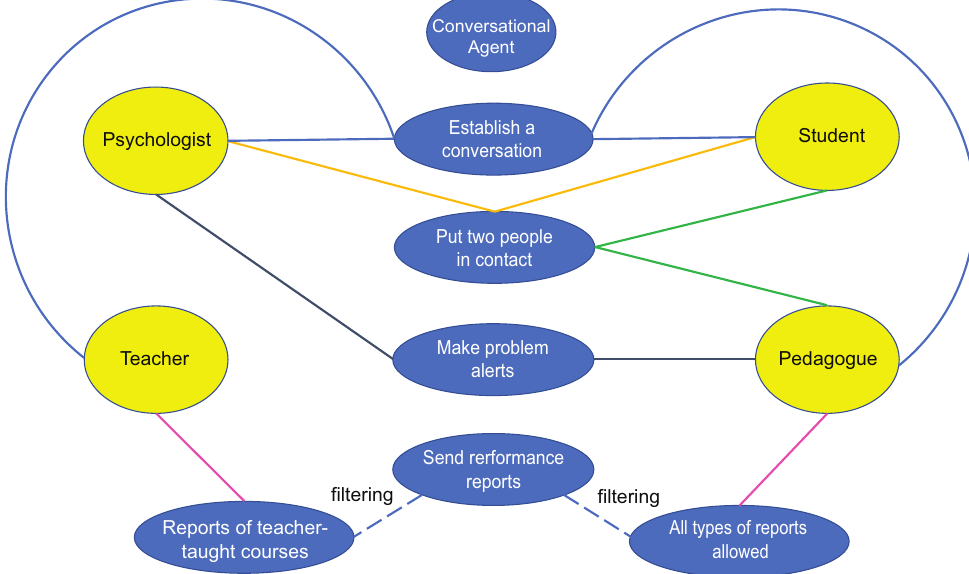
Figure 3. Some actions at the initiative of the conversational agent to help user